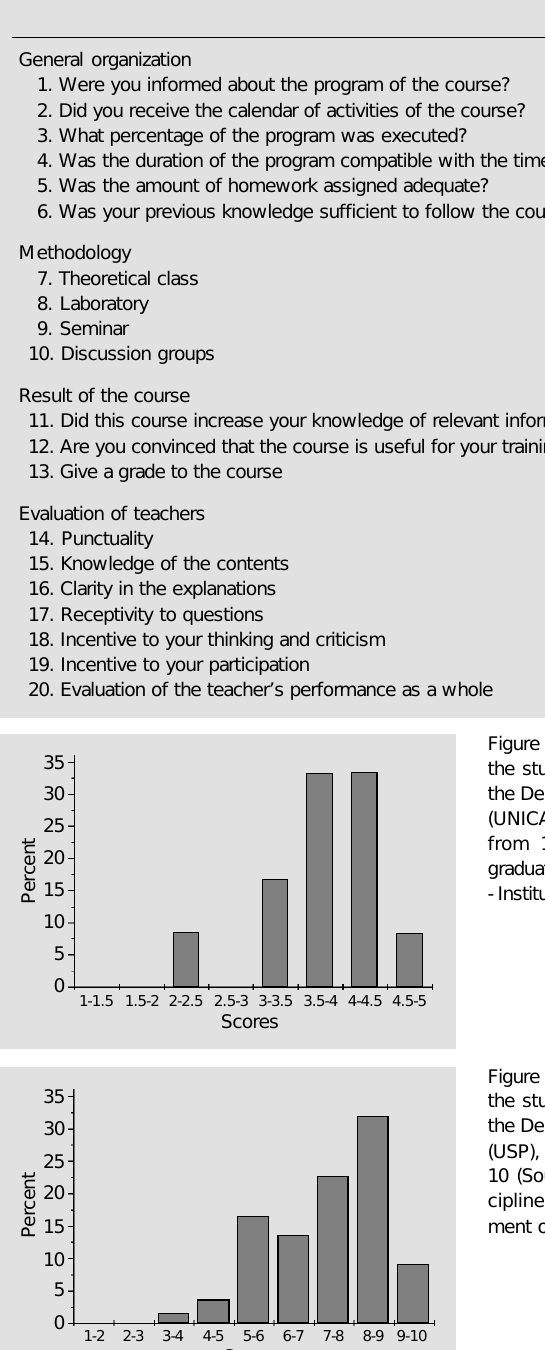
Table 4 - Evaluation of the course “Molecular Biology of Plants” (1998), given at USP.